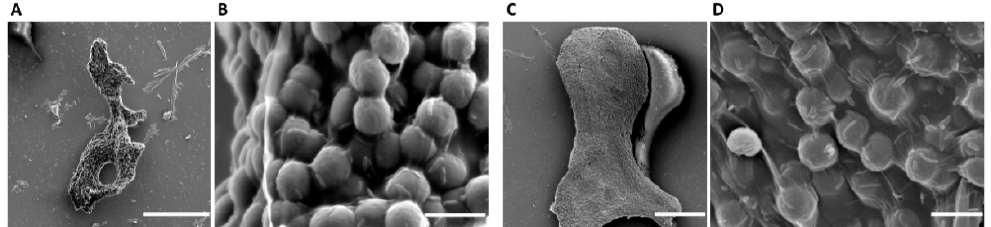
Figure 3. The SEM micrographs of the single Microcystis colonies. ( A ) Global view of a M. aeruginosa colony. ( B ) Local view of the selected M. aeruginosa colony. Bacilliform bacteria were seen on the surface of the polysaccharide shell. ( C ) Global view of a M. panniformis colony. ( D ) Local view of the selected M. panniformis colony. Bacilliform bacteria were also seen on the surface of the polysaccharide shell. Scale bars in A and C, 100 µ m. Scale bars in B and D, 5 µ m.